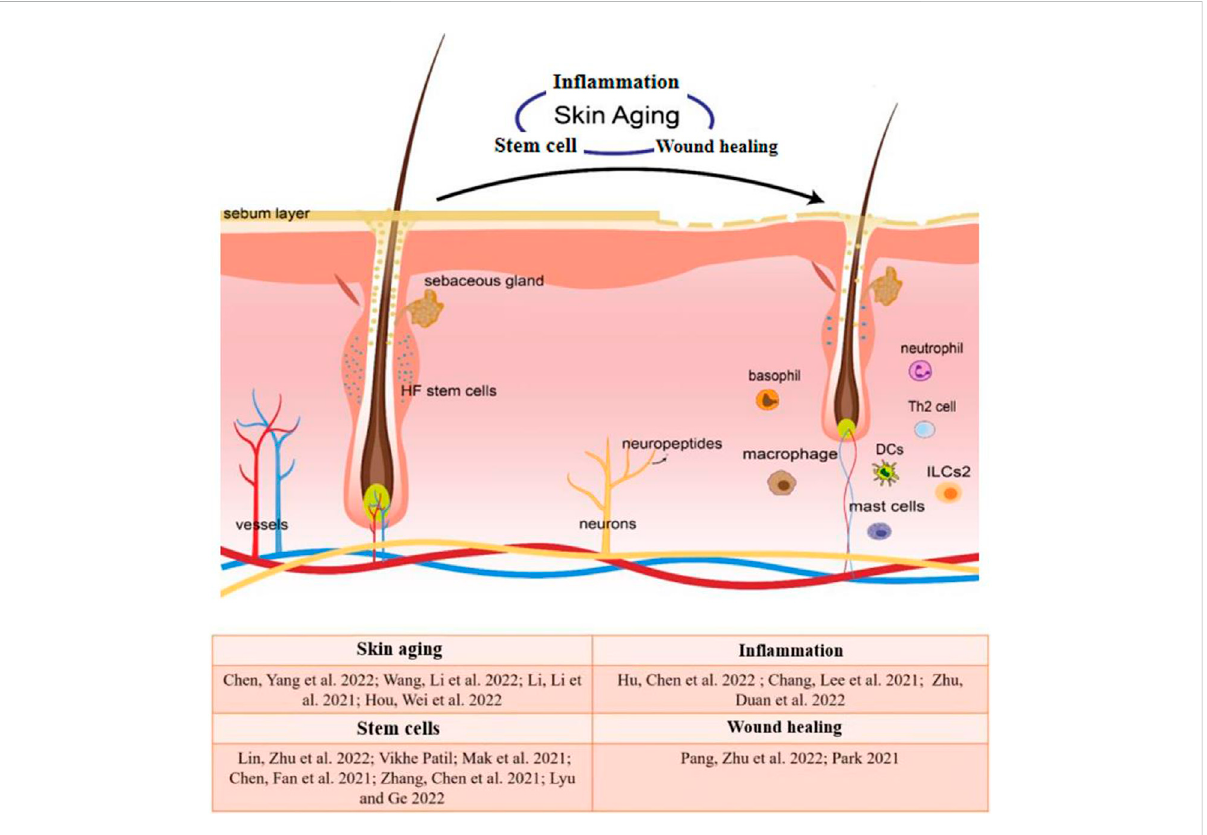
FIGURE 1 In fl ammation, stem cells and wound healing in skin aging is characterized by thinned epidermal and dermal, damaged skin barrier, smaller hair follicles, fewer HF stem cells, and minimized DP. Skin aging leads to impaired stem cell activity, chronic in fl ammation, and compromised wound healing, and is also associated with neuroimmune and in fl ammatory